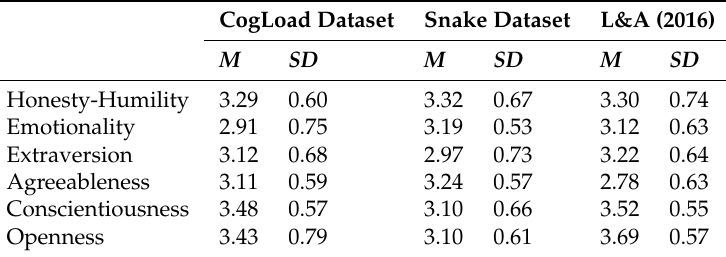
Table 2. Personality scores from the Hexaco